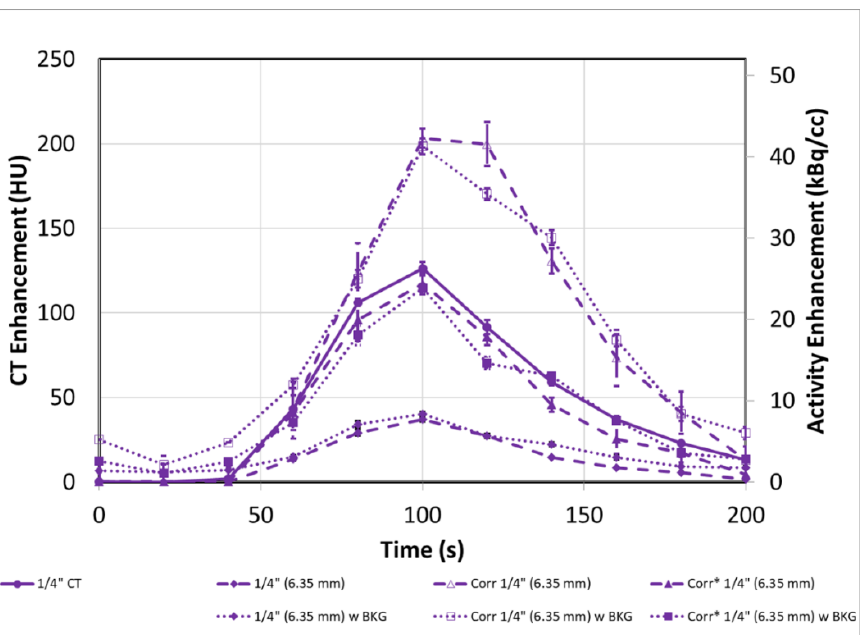
Figure 9. The overcorrection (open symbols) of the original input functions (filled circles) due to proximity of the venous tube when using Equation (2) (diamond symbols) can be corrected (Cor*) using Equation (6) (closed symbols) in both cases with and without background. PET-CT error bars represent the standard error from multiple ROI regions (n = 5). CT error bars represent the experimental range of replicate experiments (n = 2).